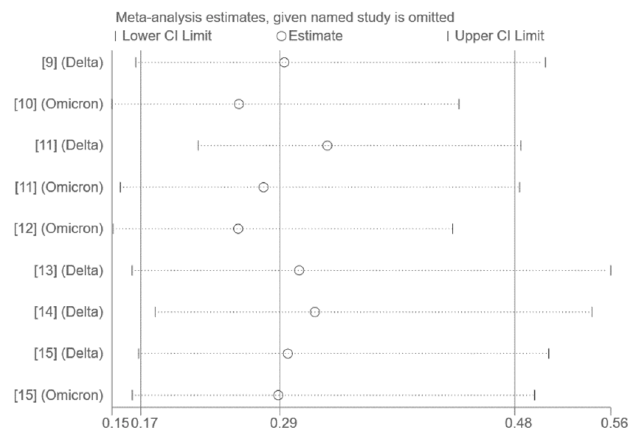
Figure 3. Sensitivity analysis (all publications) [9–15].